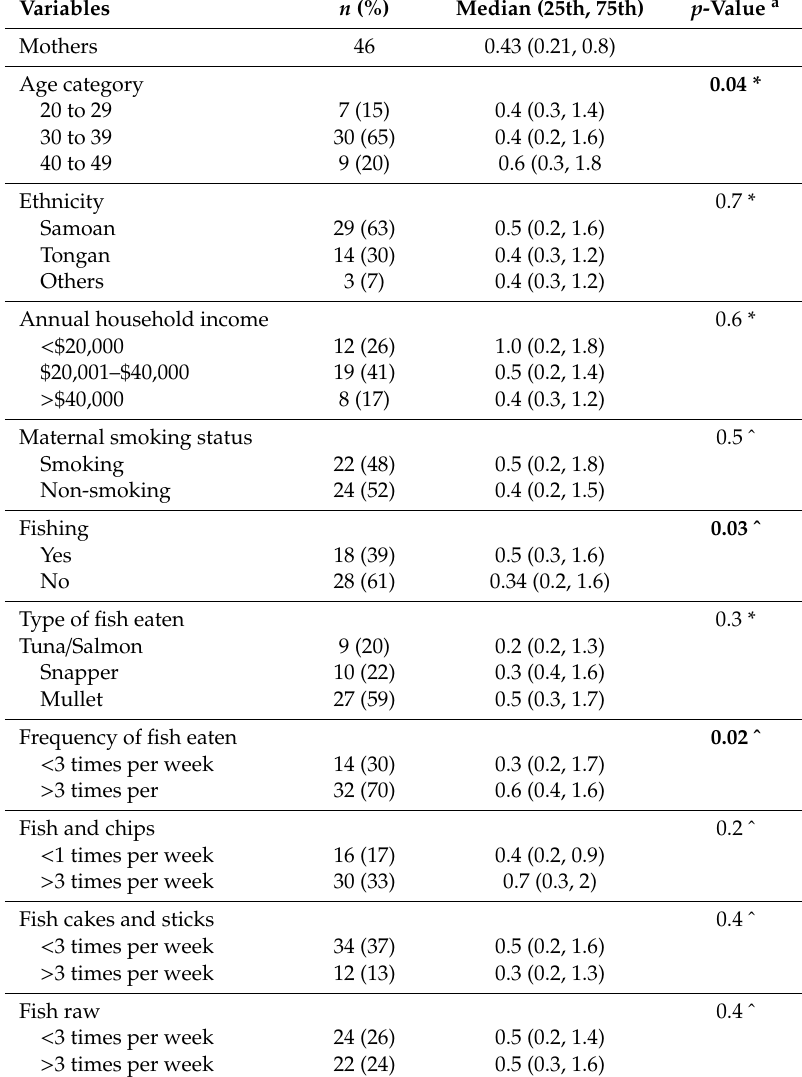
Table 3. Pacific Island mothers hair mercury concentrations ( µ g / g Hg, dry weight) based on their